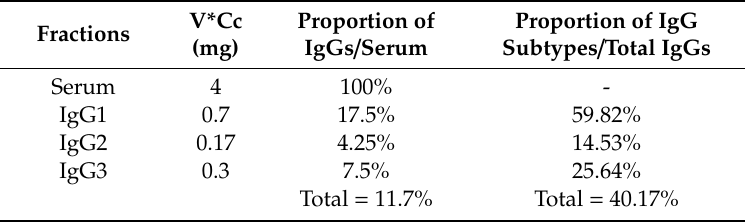
Table 1. Proportion of the di ff erent IgG fractions purified from 2 mL of hyperimmunized serum.